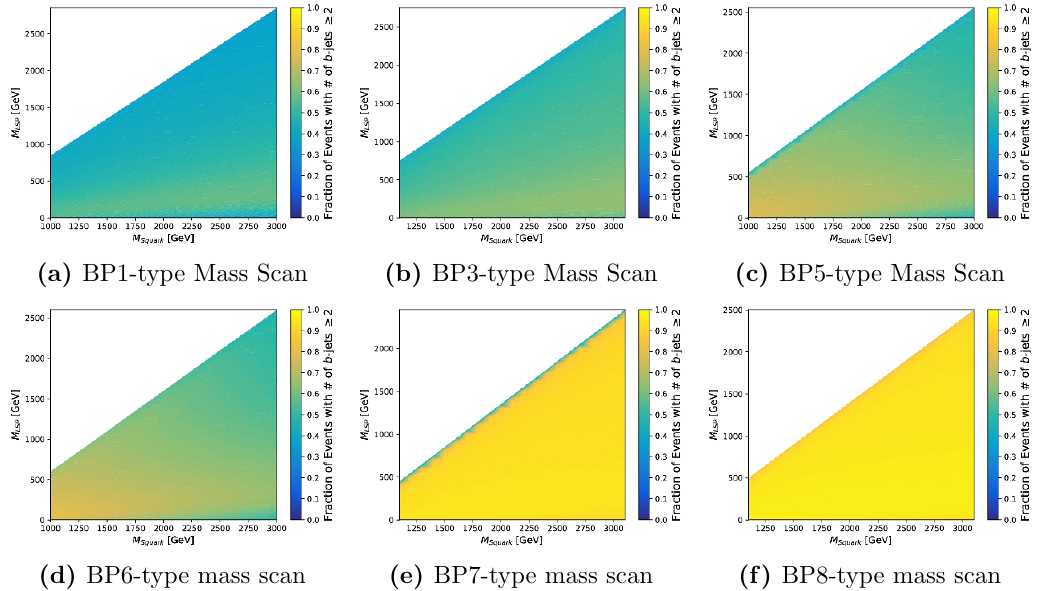
Figure 12. Fraction of events with total number of b -tagged hadronic jets greater than or equal to 2 for the BP1-BP8-type mass